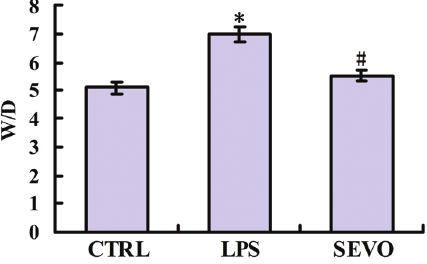
Figure 2. Lung wet to dry weight (W/D) ratios. The LPS group received 5 mg/kg lipopolysaccharide, which induced acute lung injury (ALI). The control (CTRL) group received normal saline and the SEVO group received sevo fl urane (2.5%) for 30 min after ALI was induced. Data are reported as means ± SD (n=6 per group). *P o 0.01 vs CTRL group; # P o 0.01 vs LPS group